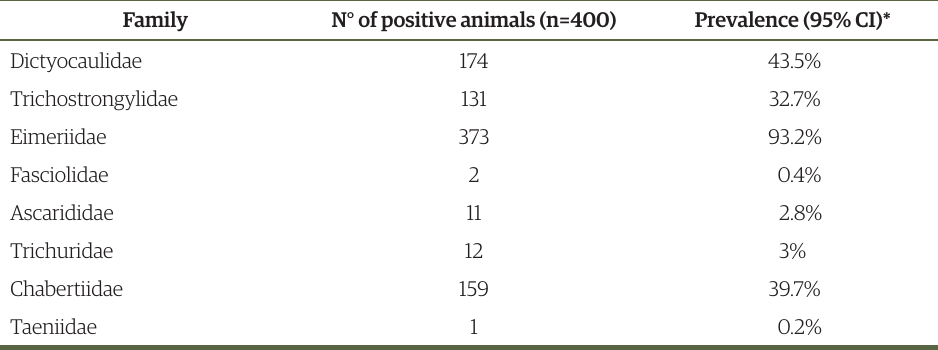
Table 1. General prevalence of gastrointestinal parasites in sheep from Ubaté, Cundinamarca, Colombia. Family N° of positive animals (n=400) Prevalence (95% CI)* Dictyocaulidae 174 43.5%